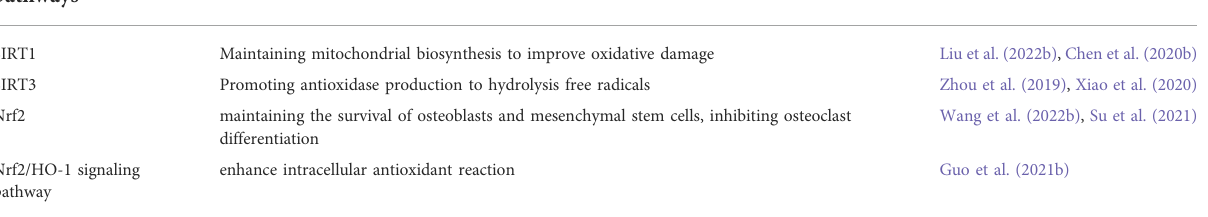
TABLE 3 Targets and signaling pathways of melatonin exerting antioxidant effects in bone metabolism. Targets and signaling